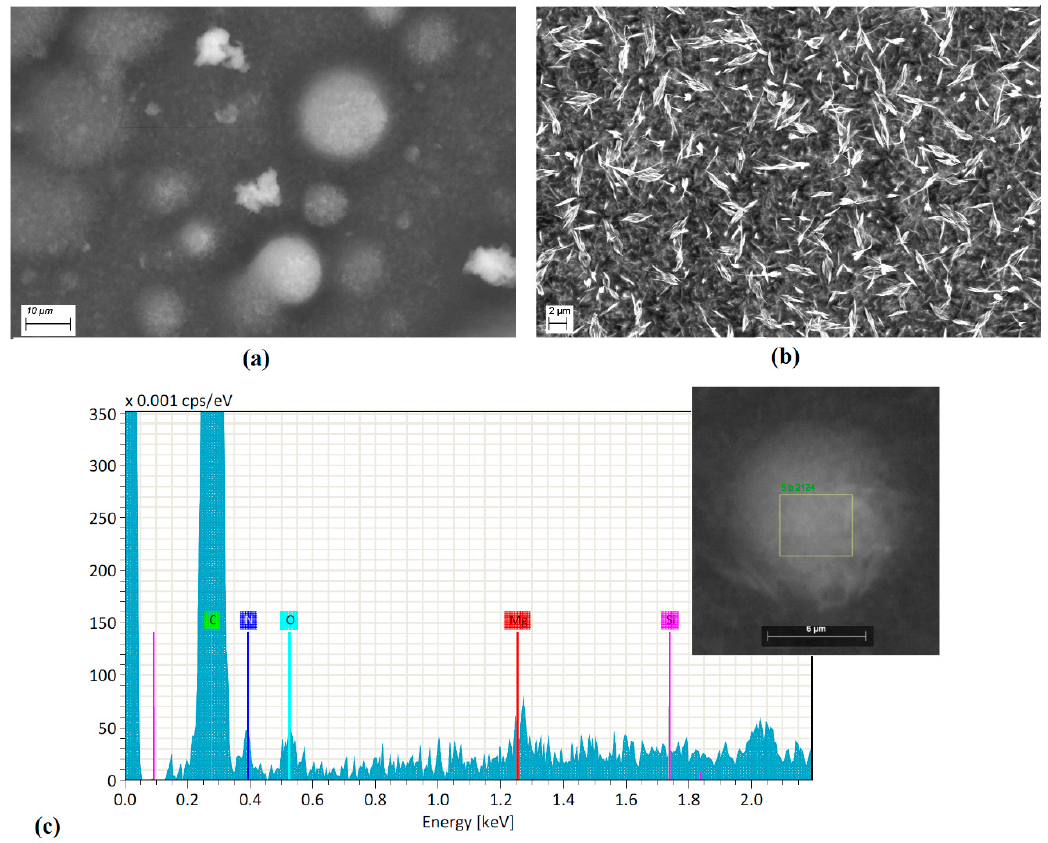
Figure 2. SEM image of ( a ) the particles within the membrane, ( b ) membrane matrix, and ( c ) EDS spectrum for particle in the membrane.